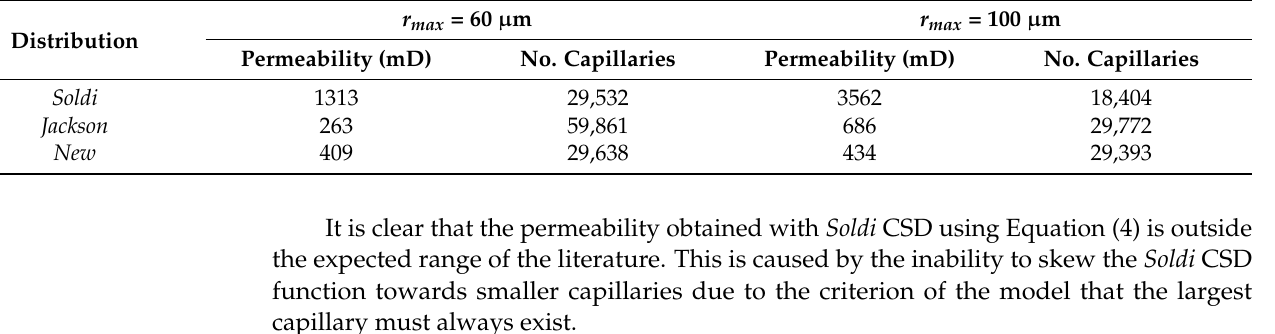
Table 3. Permeability and number of capillaries within the model for Soldi , Jackson and New CSD functions with constant capillary radius and a model porosity of 18.75% when dr c = 0.1 µ m. Distribution